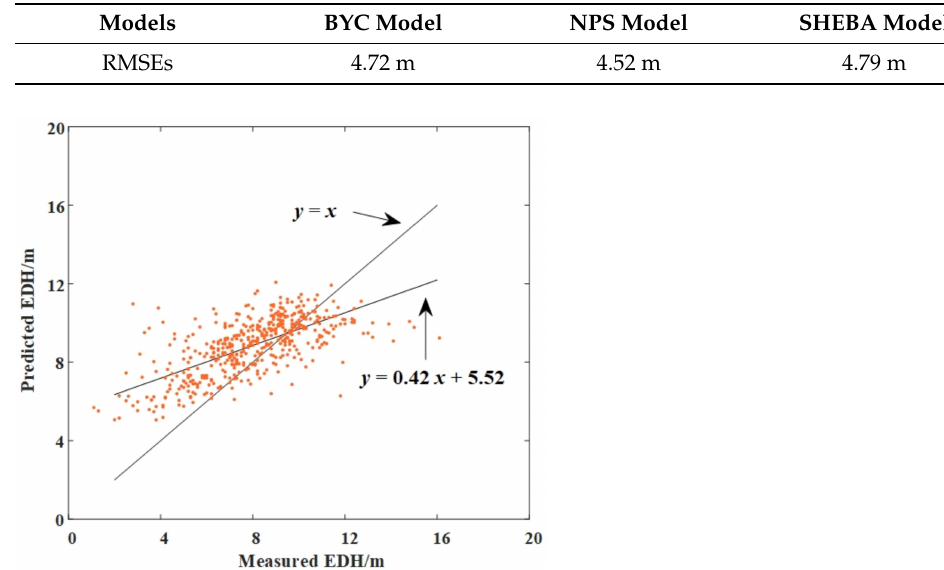
Table 3. The statistical RMSEs of three theoretical methods.